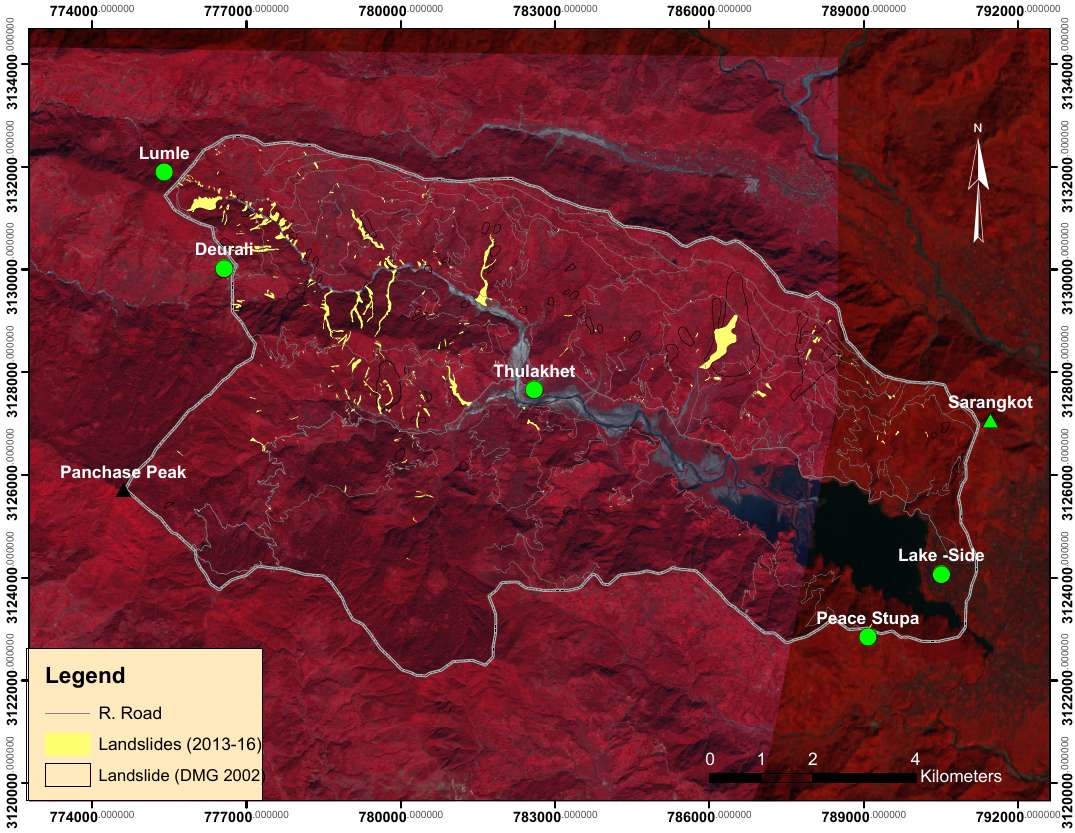
Figure 4. Inventory map (combined) of rural roads, landslides (2013–2016), and DMG 2002 [63], in a background false-color composite RapidEye image ( 5 m × 5 m) taken on 5 October 2015